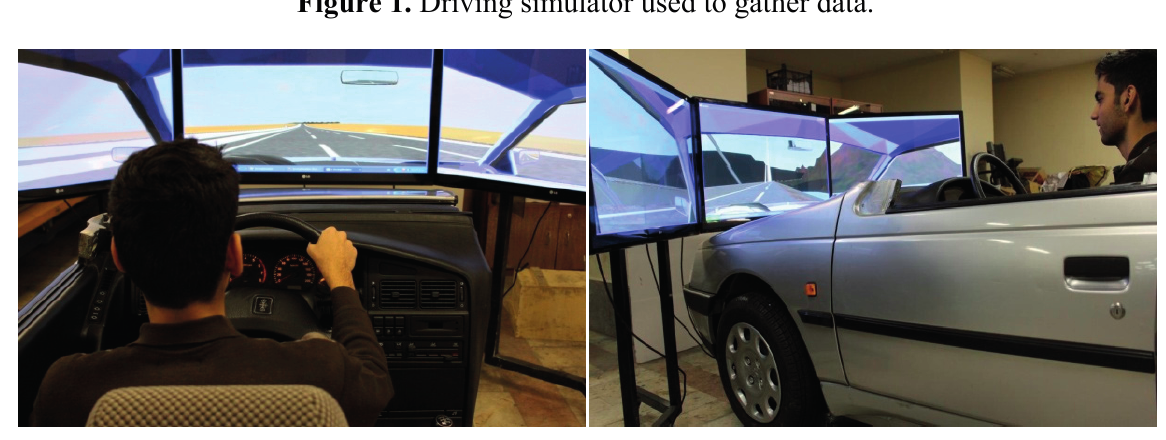
Figure 1. Driving simulator used to gather